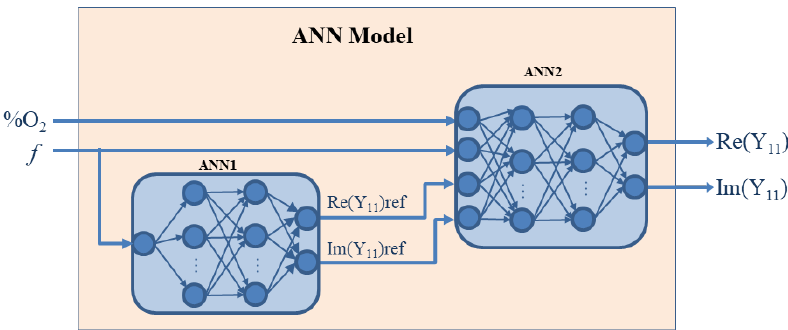
Figure 9. Illustration of the proposed artificial neural network (ANN) model for reproducing the frequency dependence of the measured Y 11 of the studied sensor operating at different concentrations of O 2 .